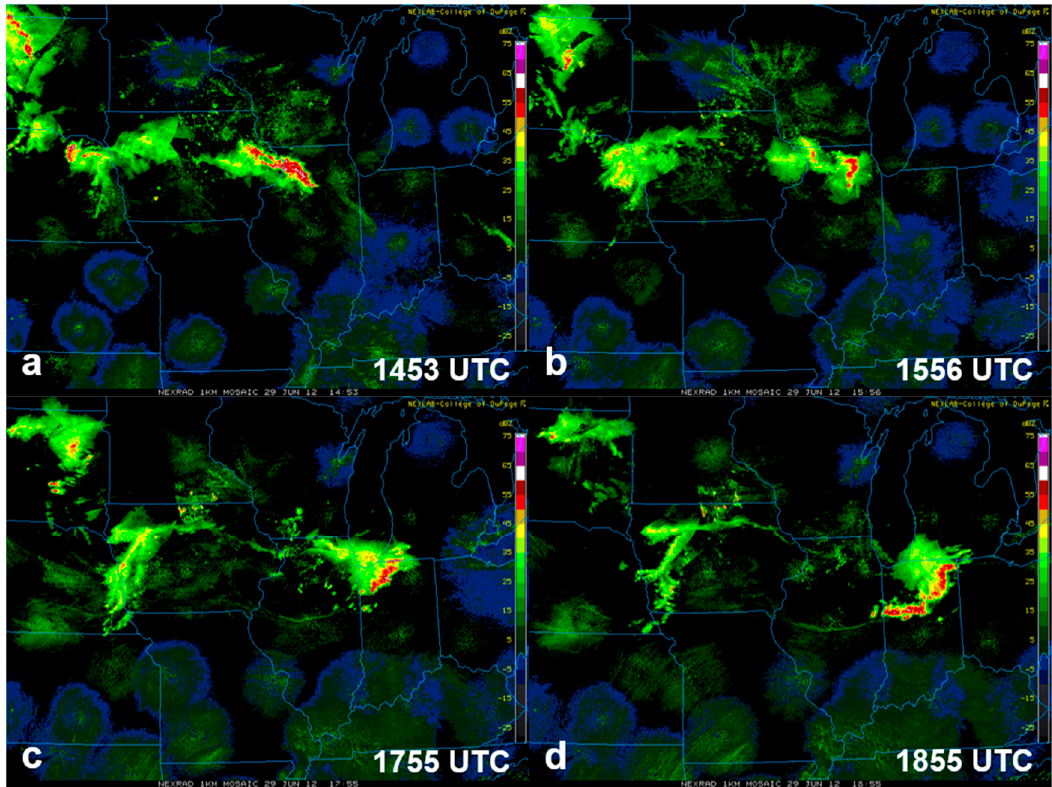
Figure 10. Four panel NEXRAD Doppler radar imagery (dBz) for ( a ) 1453 UTC, ( b ) 1556 UTC, ( c ) 1755 UTC, and ( d ) 1855 UTC on 29 June 2012 [45].